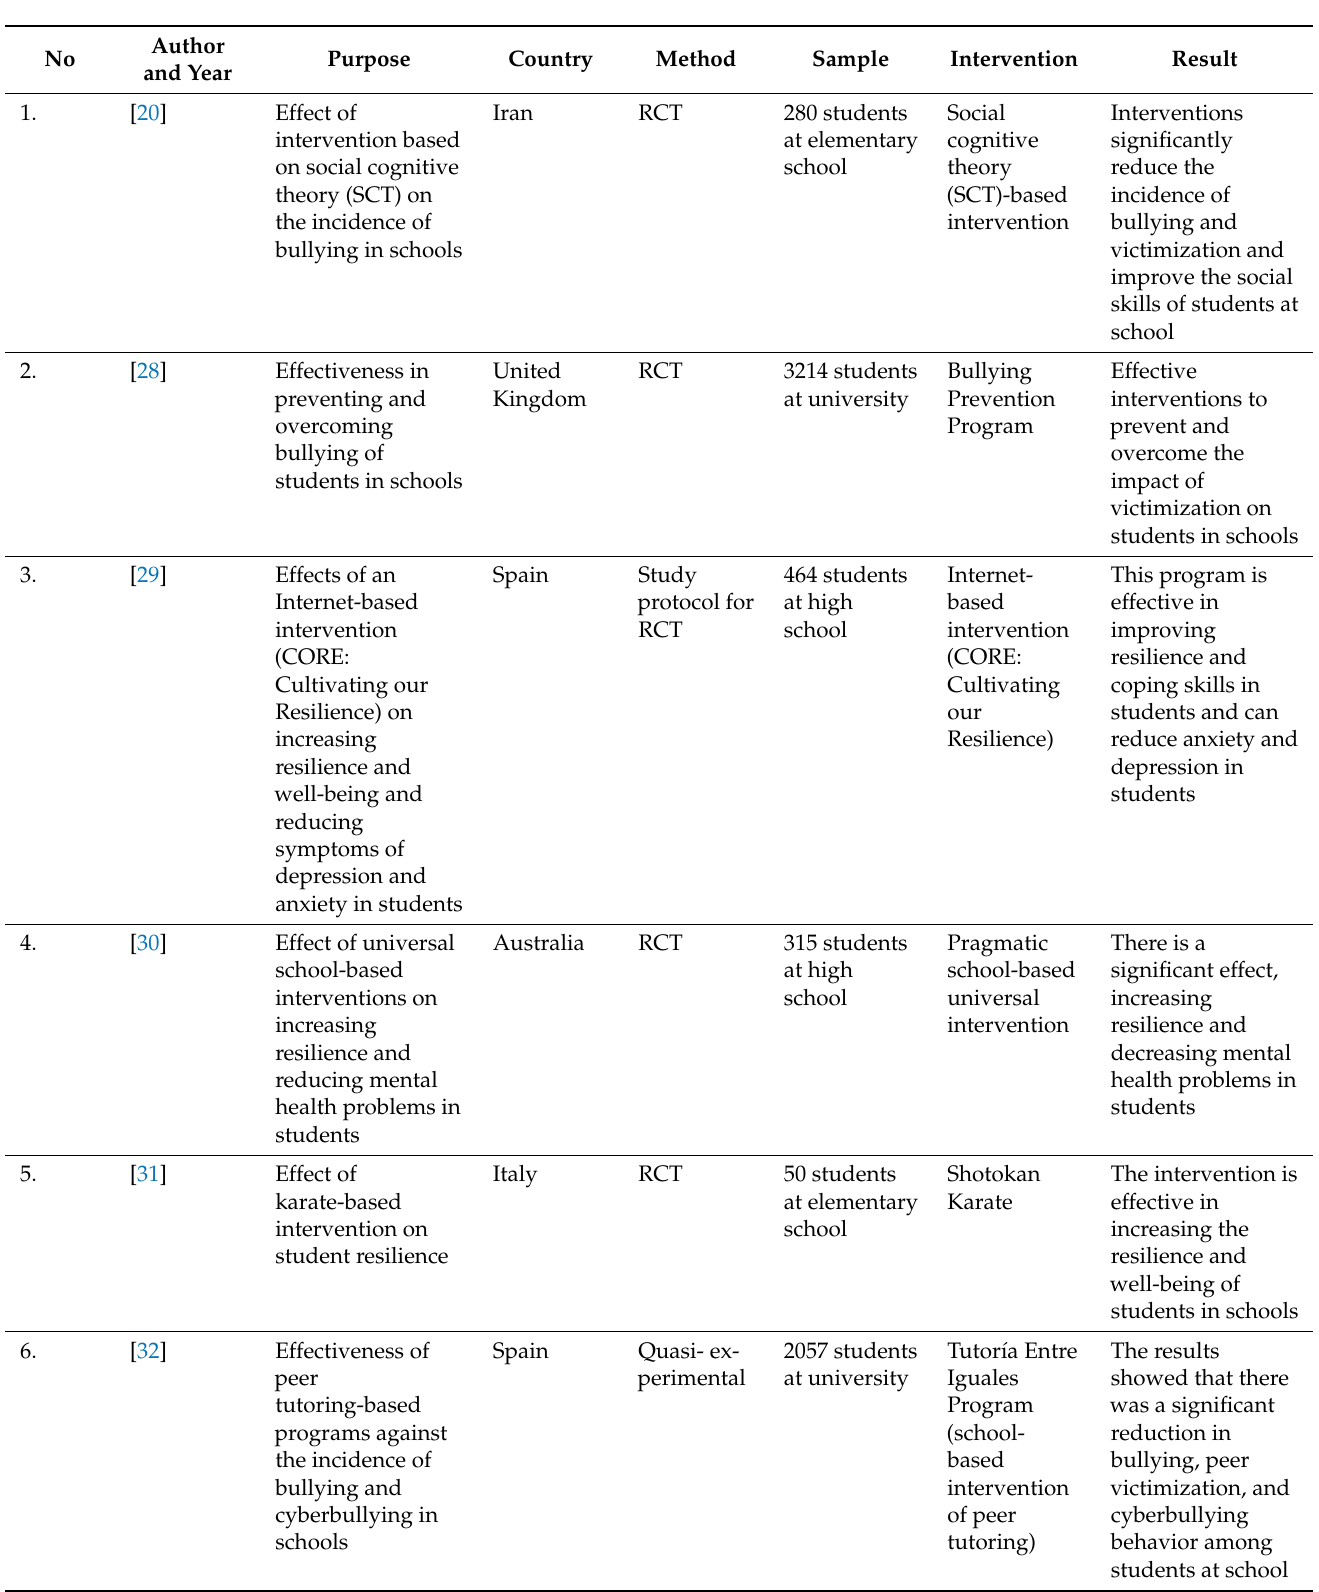
Table 2. Extraction